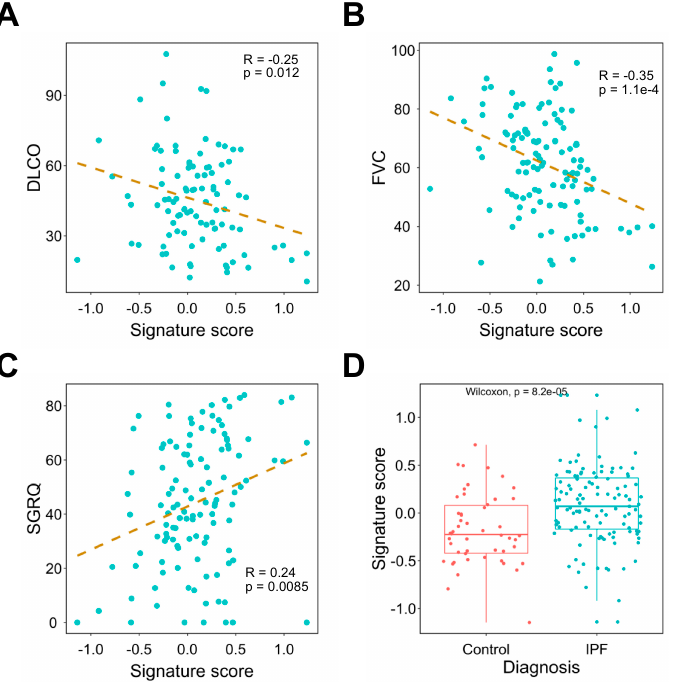
Figure 4. Investigating the association between signature expression and lung functions. ( A – C ) Correlation analysis of signature score and DLCO ( A ), FVC ( B ), and SGRQ ( C ). The dashed line represents the linear regression line. ( D ) Comparison of signature expression between IPF patients and healthy controls. DLCO: diffusing capacity for carbon monoxide; FVC: forced vital capacity; IPF: idiopathic pulmonary fibrosis; SGRQ: St. George’s Respiratory Questionnaire.